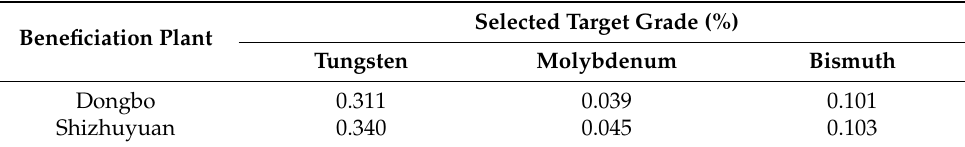
Table 2. Selected target grades of metals in the two beneficiation plants.